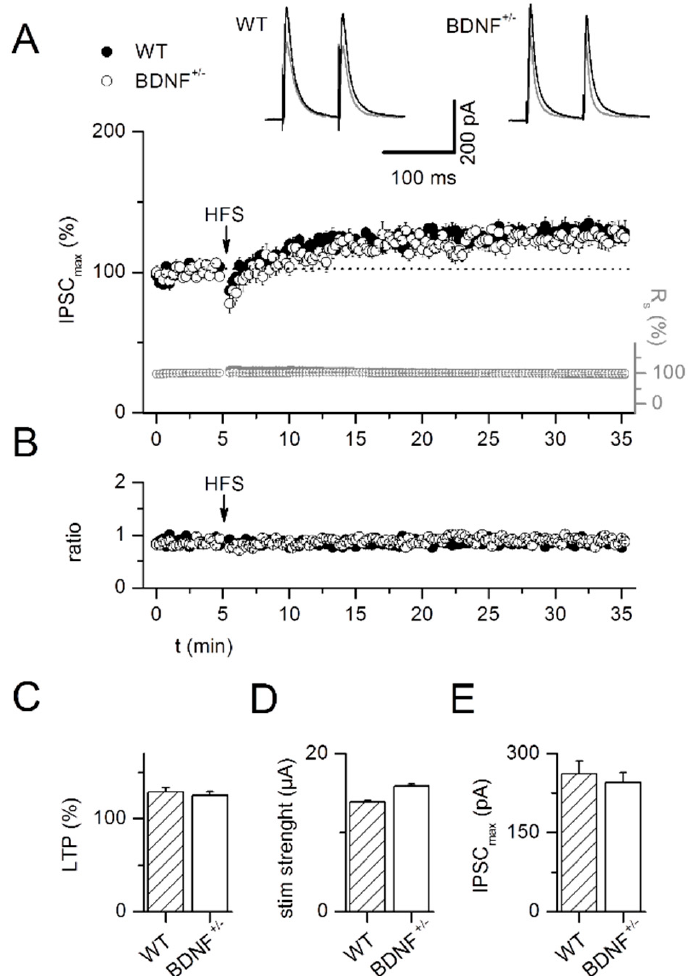
Figure 5. Intact inhibitory long-term potentiation (iLTP) of GABAergic synaptic inputs to LA projection neurons in BDNF +/ − mice. ILTP was induced by pairing a ff erent stimulation in the LA (100 Hz, 1 s) with postsynaptic depolarization to − 10 mV. ( A ) Time course of averaged evoked IPSCs and series resistance in all neurons recorded from WT and BDNF +/ − mice, respectively. In both genotypes, long-term potentiation (LTP) could be reliably induced. Insets depict averaged eIPSCs 5 min before LTP induction and during the last 5 min of recordings for WT and BDNF +/ − mice, respectively. ( B ) Paired-pulse ratio was unchanged during the time course of the experiment. ( C ) Summary of LTP expressed in the two genotypes. ( D , E ) Stimulus intensity was adjusted to elicit synaptic responses with amplitudes of 150–200 pA to control for identical induction conditions in both genotypes. Neither stimulation strength ( D ) nor amplitude of the baseline IPSCs ( E ) di ff ered between genotypes. WT: n = 10 neurons from 6 animals, BDNF +/ − : n = 9 neurons from 7 animals. 2.3. Glutamatergic Drive onto LA Interneurons Besides direct changes at GABAergic synapses, chronic BDNF reduction could modify inhibi- tory synaptic transmission indirectly through actions on the excitatory glutamatergic input to local interneurons. To test for such changes of excitatory drive on interneurons, we recorded spontaneous IPSCs (sIPSCs) in LA projection neurons before and after combined application of the glutamate receptor antagonists AP5 and DNQX. Application of these inhibitors did neither induce a significant shift in mean amplitudes nor in mean frequencies of sIPSCs in both genotypes, demonstrating a lack